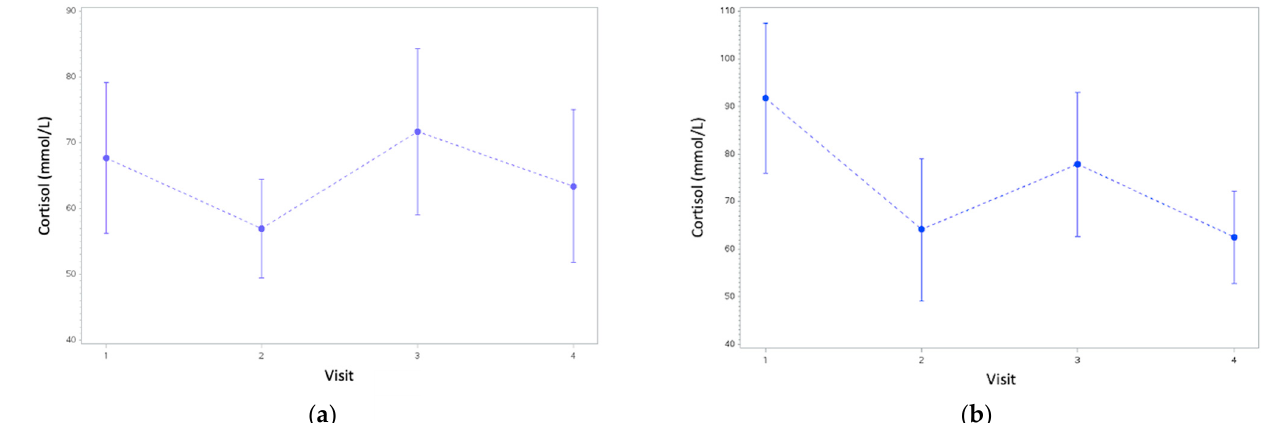
Figure 6. Cortisol values from the first to fourth visit for ( a ) the control group and ( b ) the intervention group.